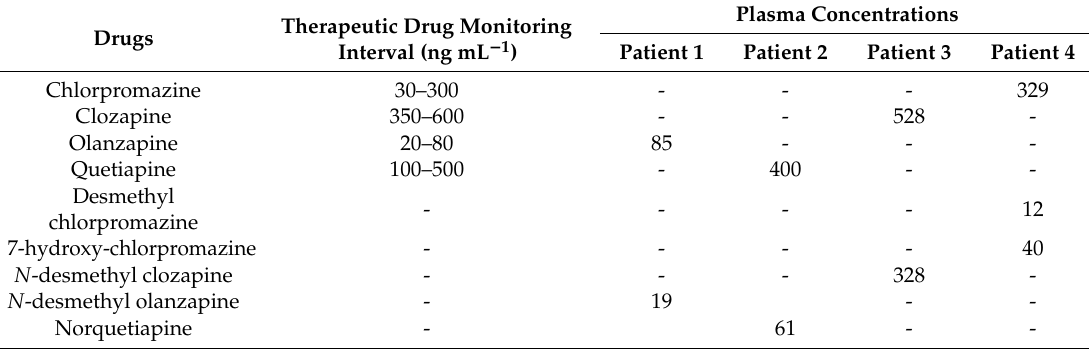
Table 6. Concentrations of the target antipsychotic and their metabolites in plasma samples from Schizophrenic